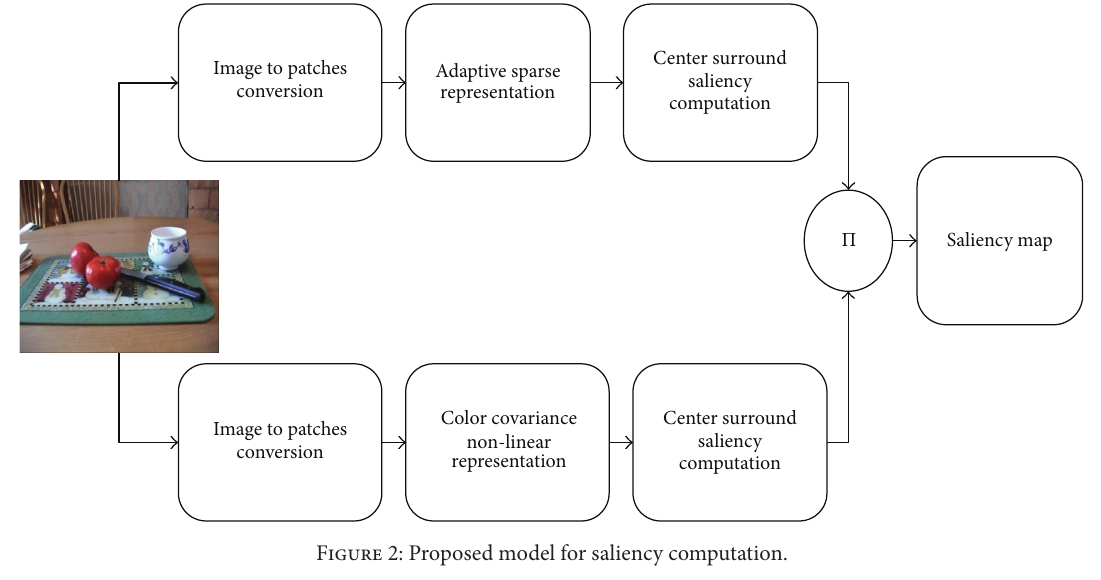
Figure 2: Proposed model for saliency computation.